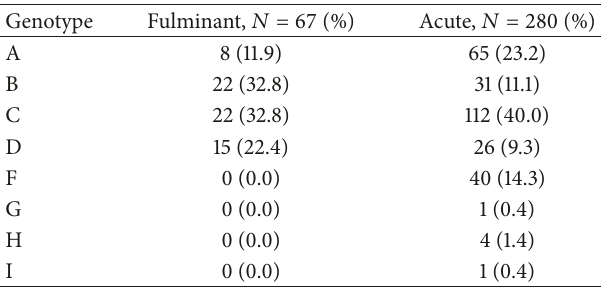
Table 1: Genotype distribution of fulminant and acute nonfulmi- nant hepatitis B viral genomes retrieved from